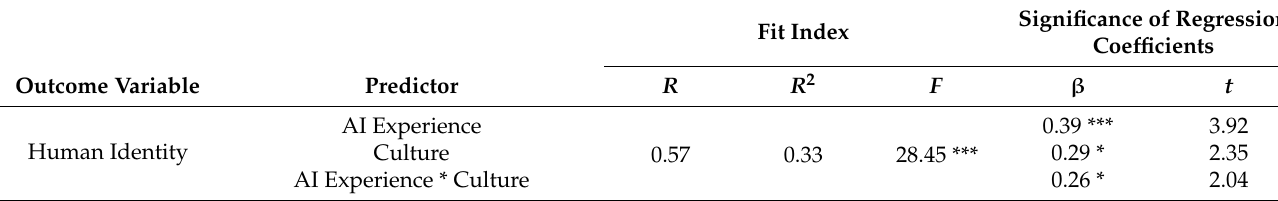
Table 9. Multiple linear regression with interaction, Study 3.